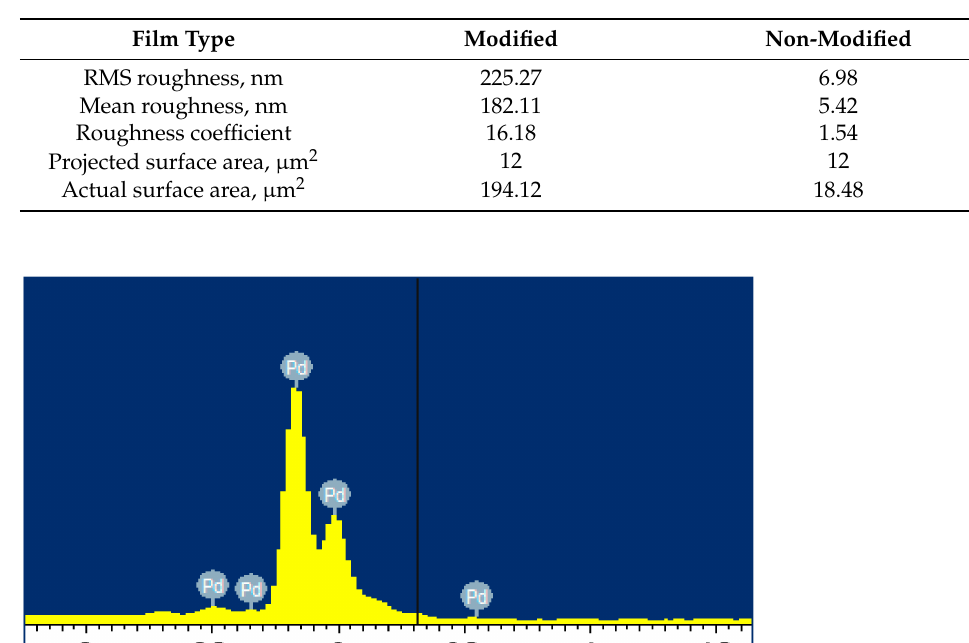
Figure 1. Microphotographs of the PdCu–Nb–PdCu films surface modified with palladium nanocrys- tallites at a magnification of 500 ( a ), 5000 ( b ), 30,000 ( c ), 50,000 ( d ). Table 1. Statistical data of the surface morphology parameters of the PdCu–Nb–PdCu film modified with a nanostructured coating and non-modified film.